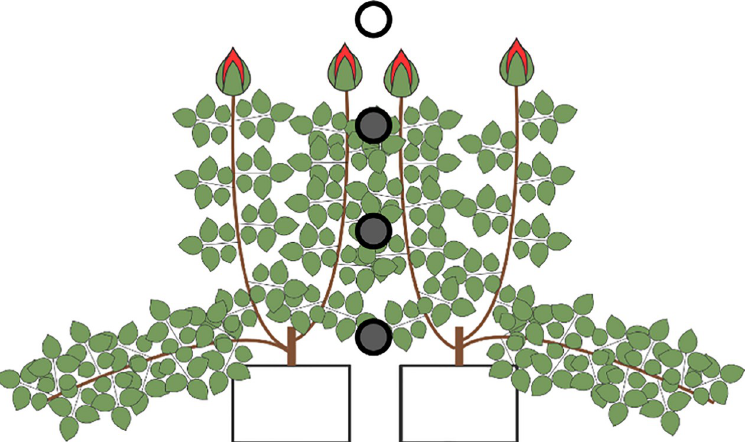
Fig 1. Set-up of the canopy climate measurements. The open circle refers to the reference sensor and the climate box that measures the ambient climate. The filled circles indicate the location of PAR , temperature and relative humidity measurements. The top sensor was positioned at a height of 1.8m from the ground, which was just above the canopy when the canopy was fully developed. The other sensors were placed at an interval of 0.3m.